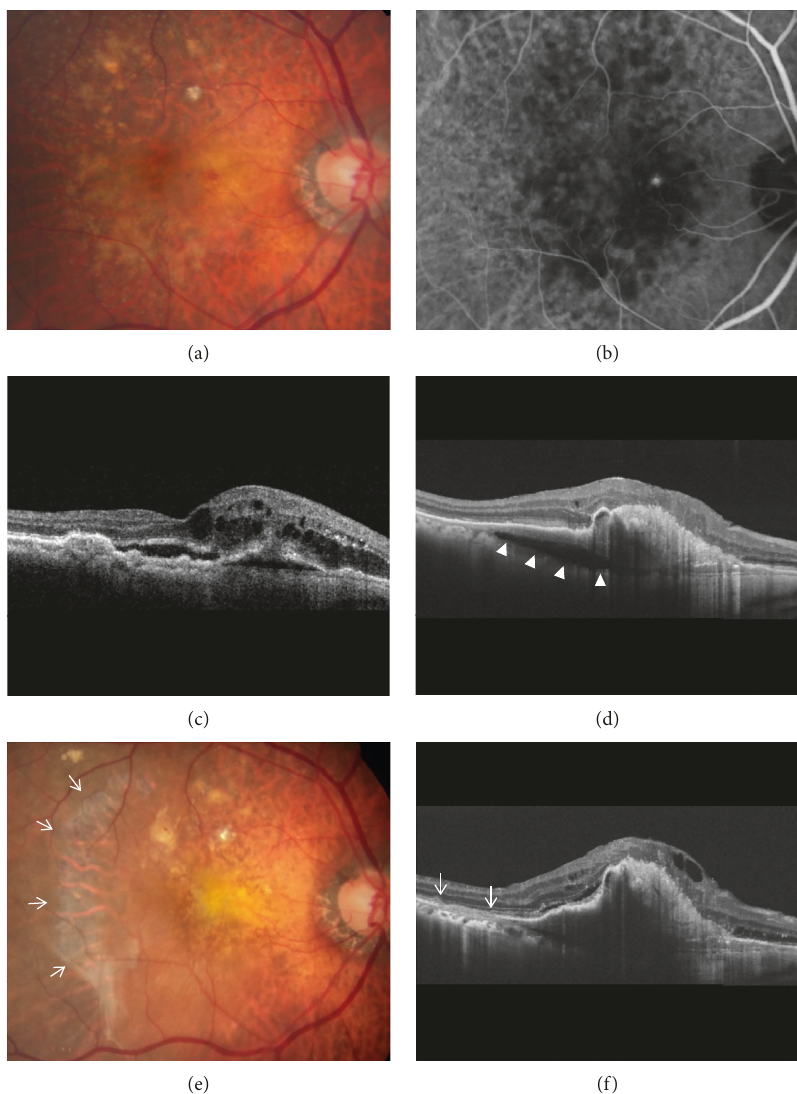
Figure 3: Fundus photography (a, e), indocyanine green angiography (b), and optical coherence tomography (c, d, f) images of a patient diagnosed with type 3 neovascularization. The images were taken at diagnosis (a–c), at 29 months (d), and at 35 months (e, f). The patient was treated with antivascular endothelial growth factor monotherapy during the follow-up period. Development of prechoroidal cleft was identified at 29 months (d) (arrowheads). Six months later, retinal pigment epithelium tear developed (e, f, arrows). Sixteen antivascular endothelial growth factor injections were performed during the follow-up